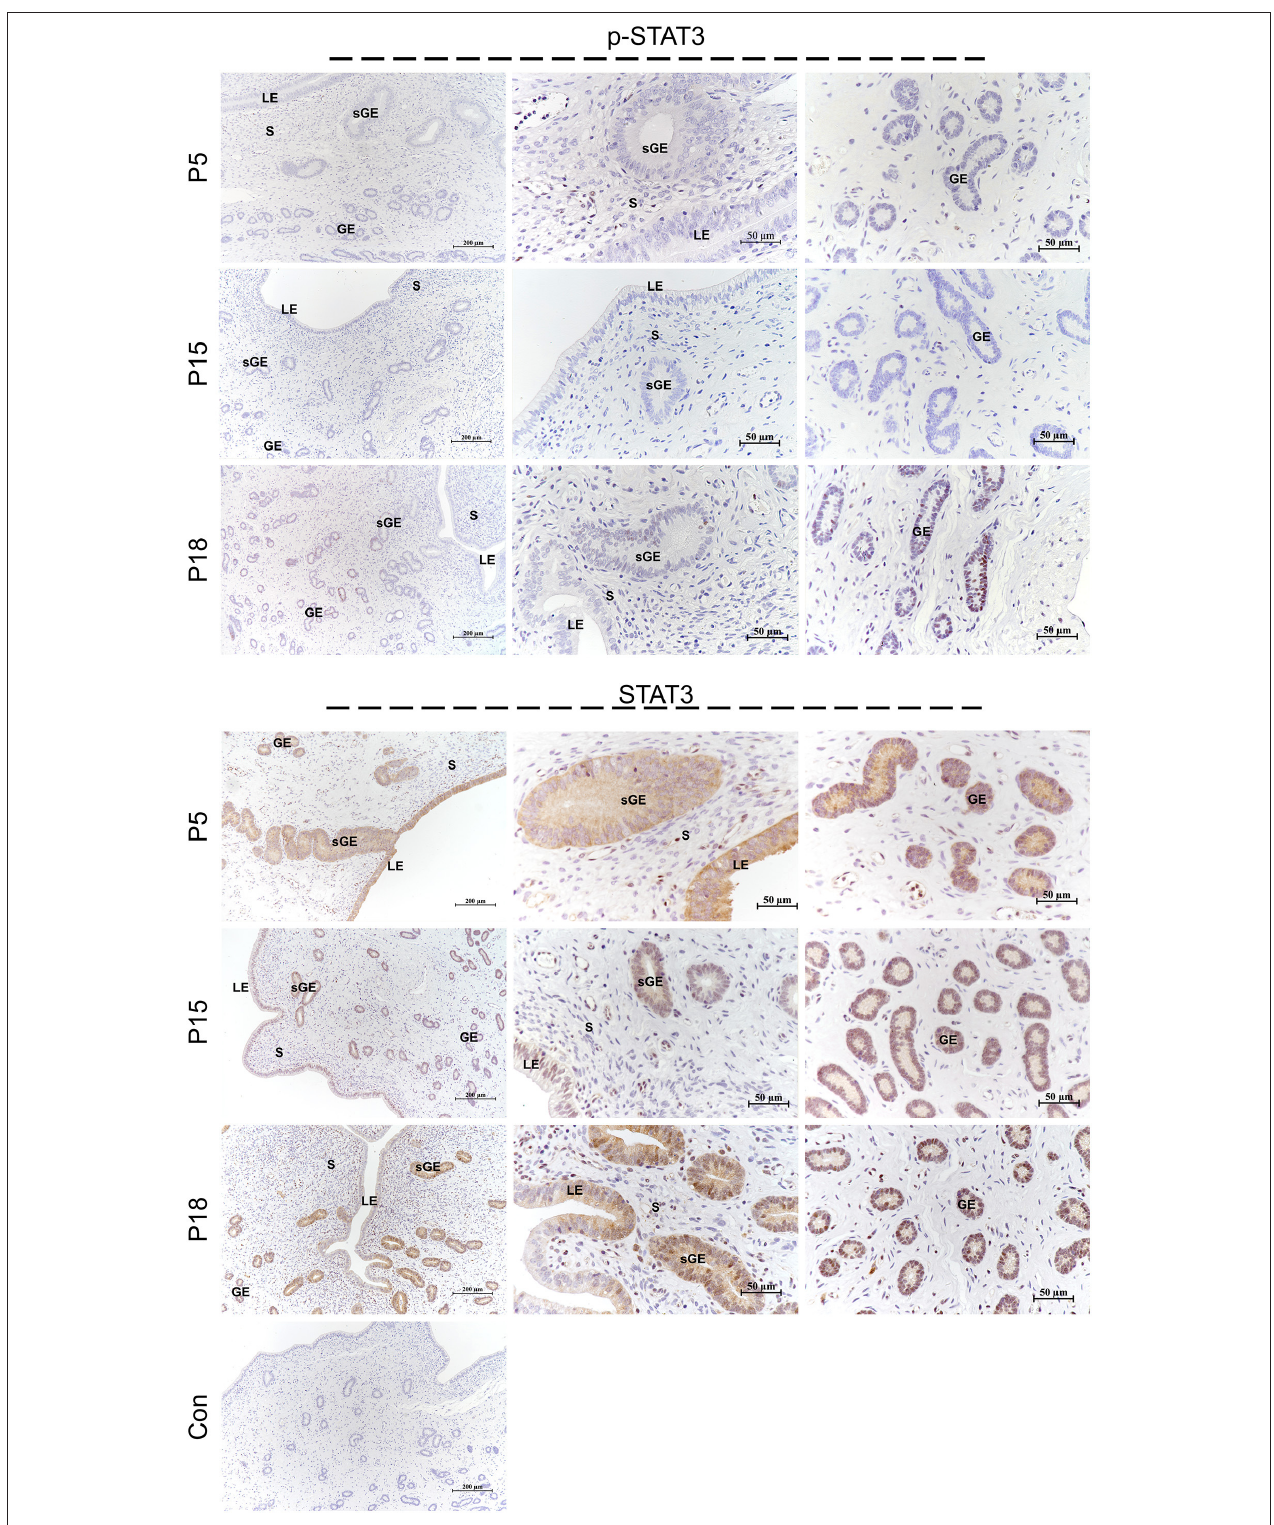
FIGURE 7 | Immunolocalization of p-STAT3 and STAT3 in goat uterus during early pregnancy. For Control, preimmune serum was substituted for the primary antibody. LE, luminal epithelium; GE, glandular epithelium; sGE, superficial glandular epithelium; S, stroma.